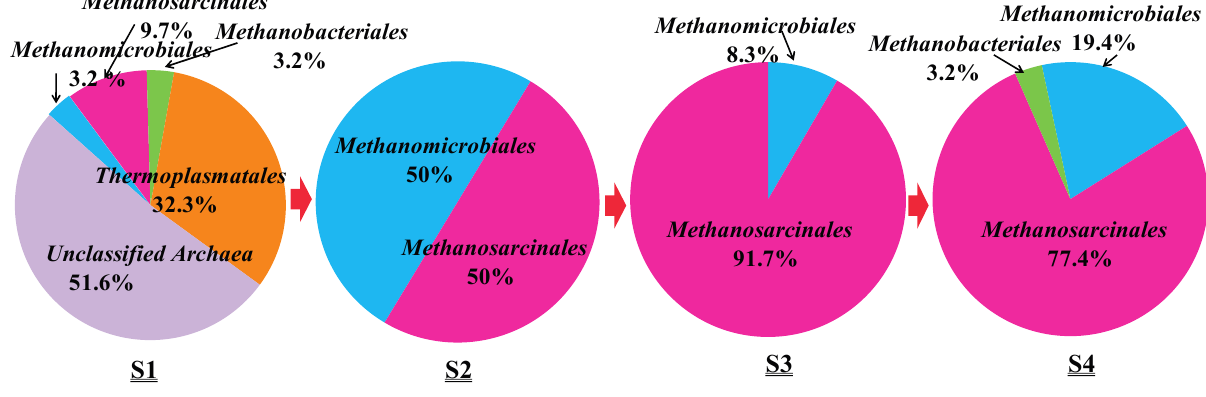
Figure 5. Relative abundance of archaeal orders detected in S1–S4 samples from an oilfield